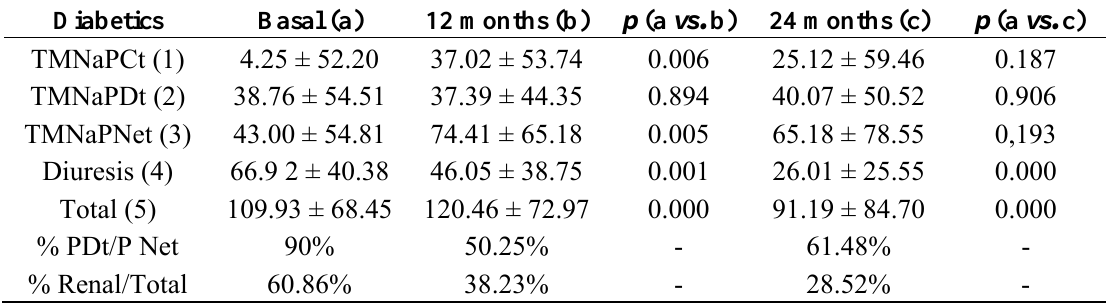
Table 7. Sodium balance